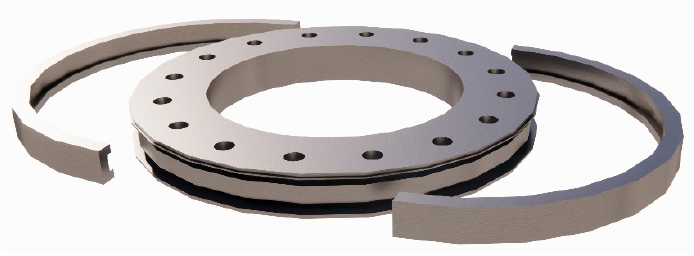
Figure 2. Combination Splice.